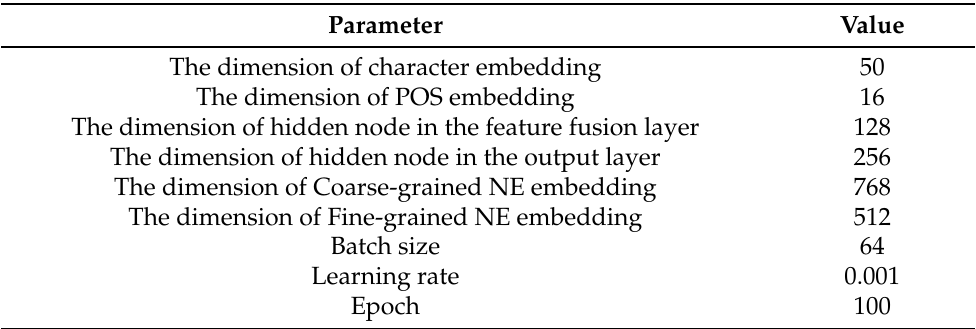
Table 4. Model parameters.